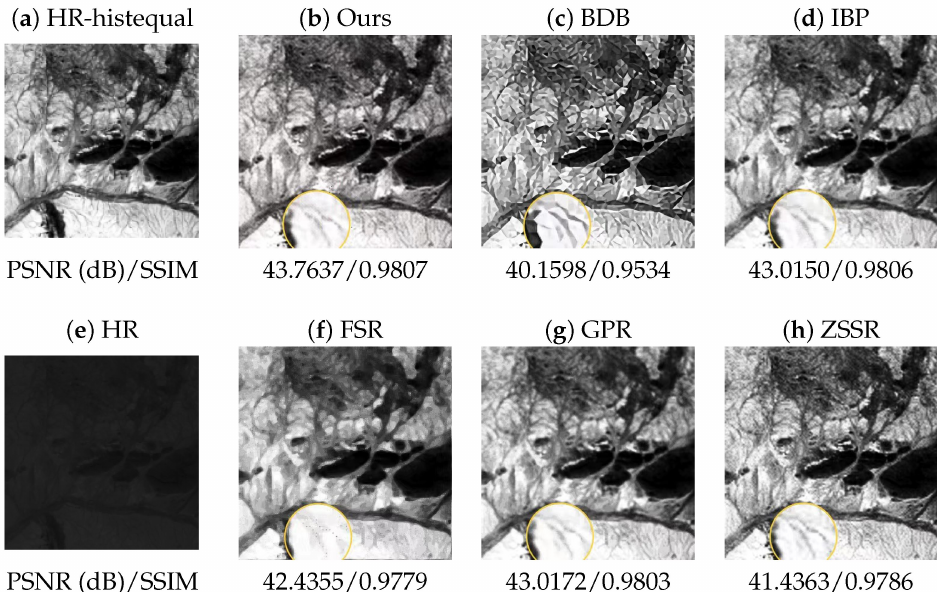
Figure 4. Visual results of our method and other unsupervised methods (BDB [33], IBP [20], FSR [55], GPR [56], and ZSSR [36]) on the PROBA-V dataset. Since the pixel value of the infrared HR image